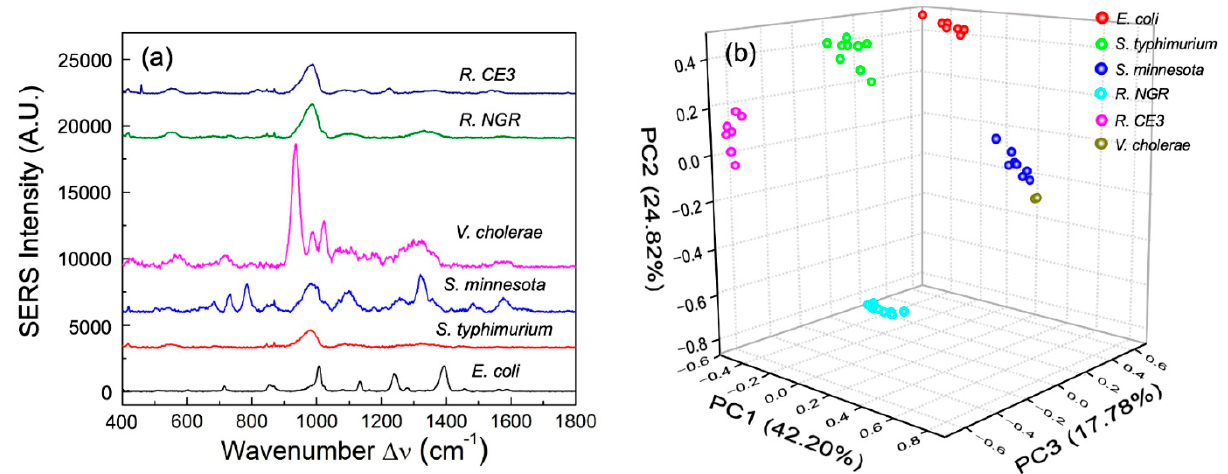
Figure 2. Different enteric LPS Raman SERS spectra. ( a ) SERS spectra of different enteric LPSs obtained from E. coli , S. typhimurium , S. minnesota , V. cholerae , R . CE3, and R . NGR. ( b ) PCA score plot of six enteric LPSs based on their SERS spectra.